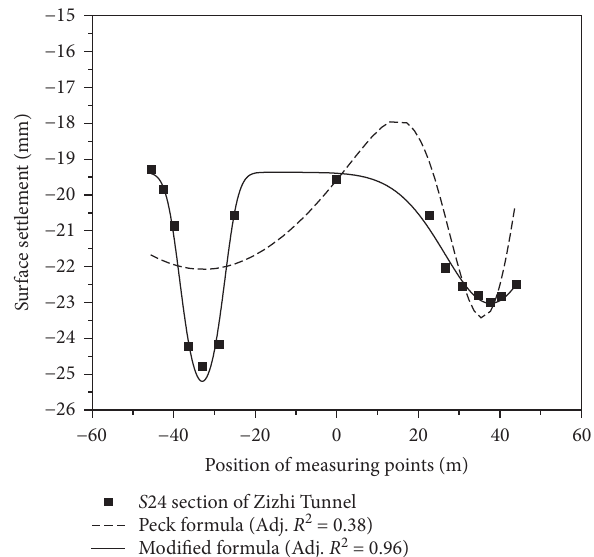
Figure 11: Surface settlement of S 24 section inside the river-af- fected